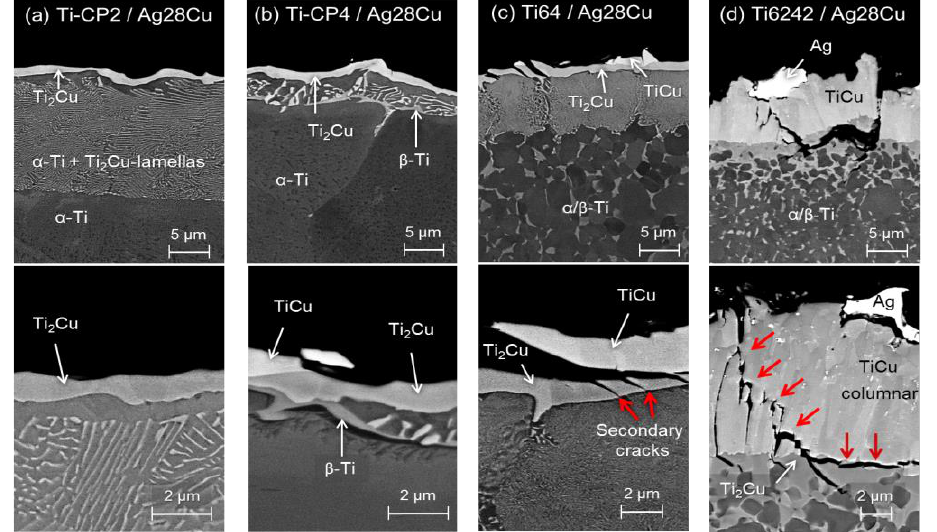
Figure 9. SEM - Micrographs of longitudinal sections of the fractured tensile specimen excluding the joints at low ( top row ) and high ( bottom row )